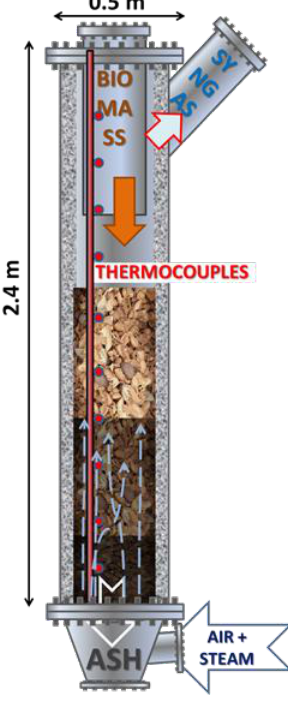
Figure 1. Updraft gasifier scheme.